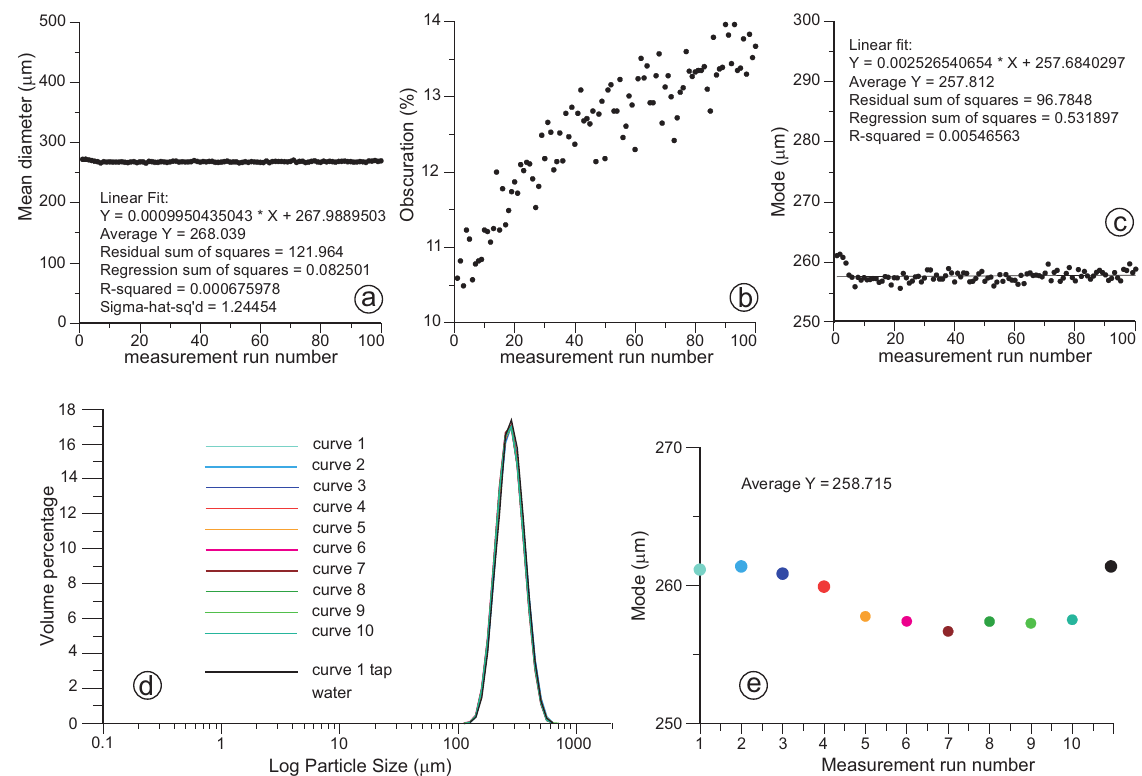
Fig. 18. Results of the chemical test MP2500 5al performed on sub-sample aliquot SAND1e by the Hydro 2000 MU dispersion unit, using denaturated ethyl alcohol as dispersant liquid. (a) Mean diameter value evolution with increasing the number of measurement runs. Data statistics is provided. (b) Laser obscuration value progression during the same test. (c) Progression of modal values with increasing the number of measurement runs. Data statistics are provided. (d) Granulometric curves computed for the first 10 runs, compared with the first curve from the test MP2500 5 on sub-sample aliquot SAND1c (Fig. 8). (e) Modal values corresponding to the curves in